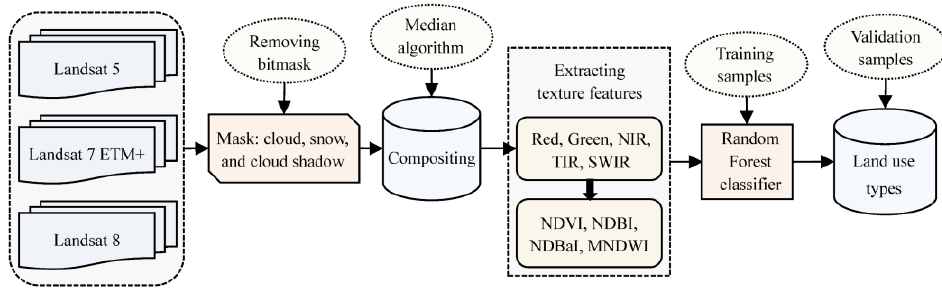
Figure 2. Schematic illustration of land use interpretation in GEE. Secondly, the bands of red, green, near-infrared, short-wave infrared, thermal infra- red were extracted from the composited imageries to detect textural features for classifi- cation. The textural features included Normalized Difference Vegetation Index (NDVI), Normalized Difference Built-up Index (NDBI), Normalized Difference Bareness Index (NDBaI), and Modified Normalized Difference Water Index (MNDWI).